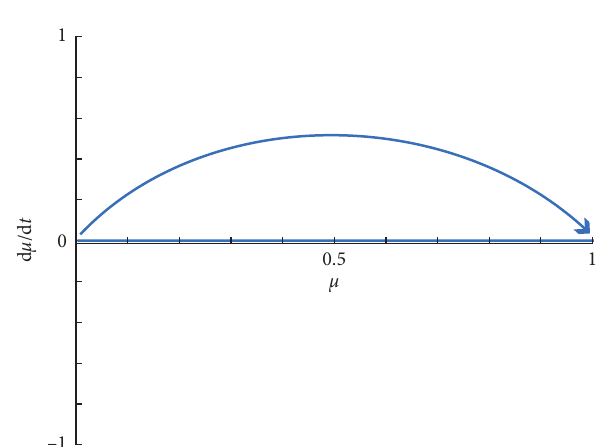
Figure 8: The evolution phase diagram of η < η ∗